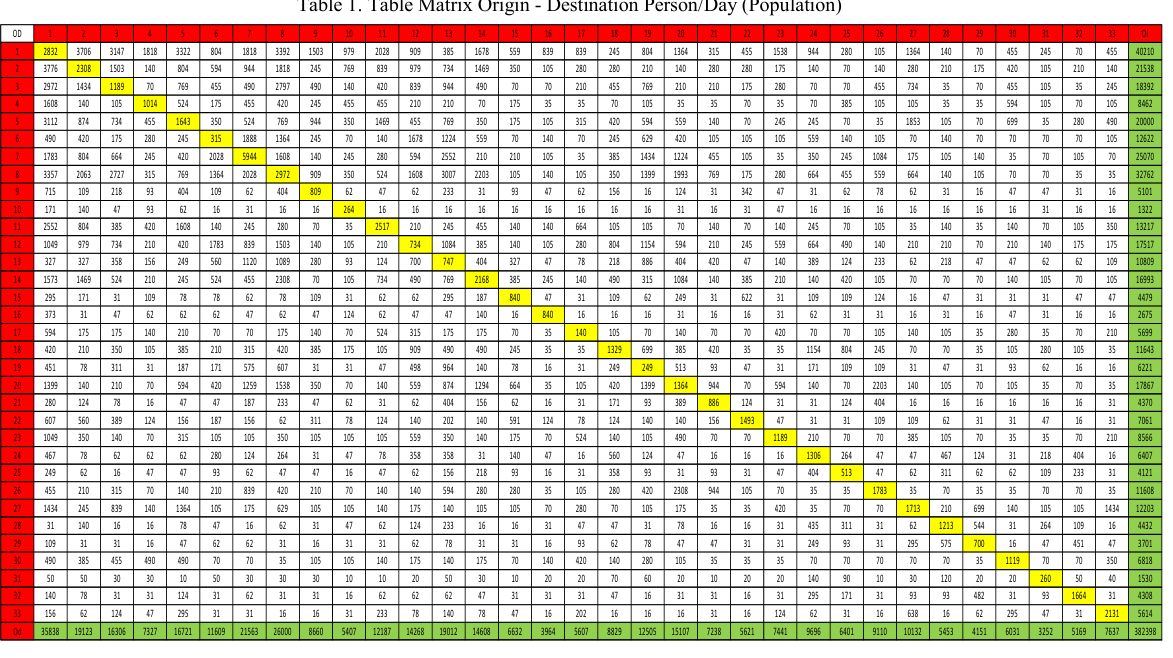
Source: Results of